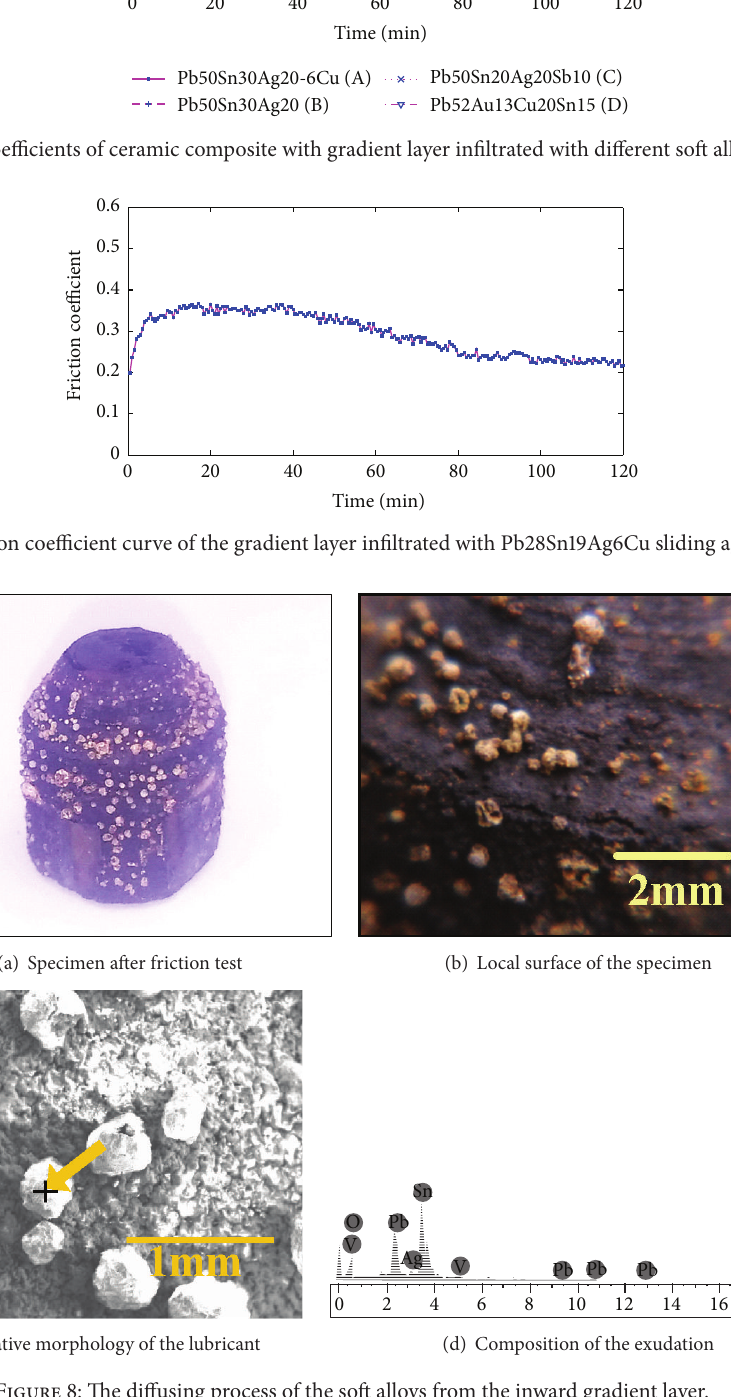
Figure 8: The diffusing process of the soft alloys from the inward gradient